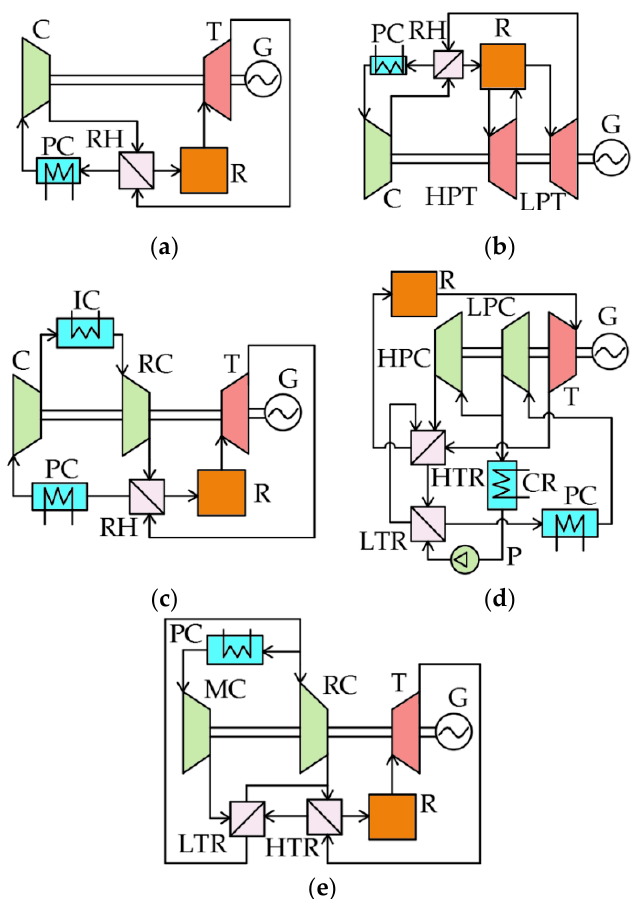
Figure 1. Supercritical CO 2 Brayton cycles: ( a ) S-CO 2 Brayton cycle with regeneration; ( b ) S-CO 2 Brayton cycle with reheating; ( c ) S-CO 2 Brayton cycle with intermediate cooling; ( d ) S-CO 2 Brayton cycle with partial cooling; ( e ) S-CO 2 Brayton cycle with recompression. C—compressor, RH—regenerator, R—reactor, T—turbine, G—electricity generator, PC—pre-cooler, HTP—high-pressure turbine, LPT—low-pressure turbine, CR—cooler, P—pump, RC—recompressing compressor, HTR—high-temperature regenerator, LTR—low-temperature regenerator, MC—main compressor, and IC—intermediate cooler.